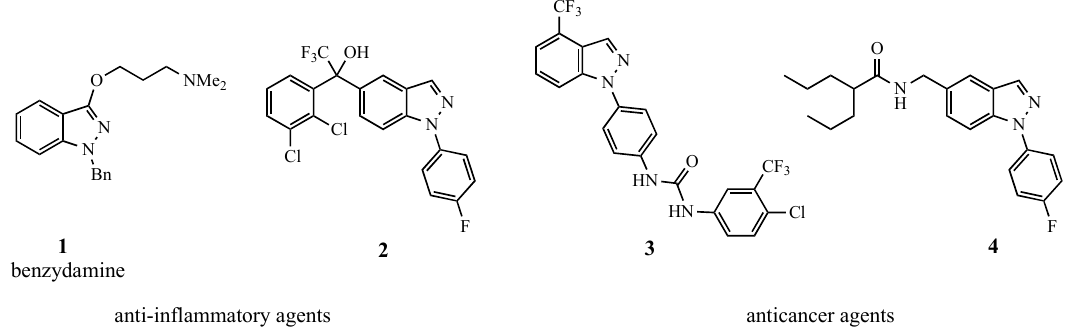
Figure 1. Drugs incorporating 1-aryl-1 H -indazoles.